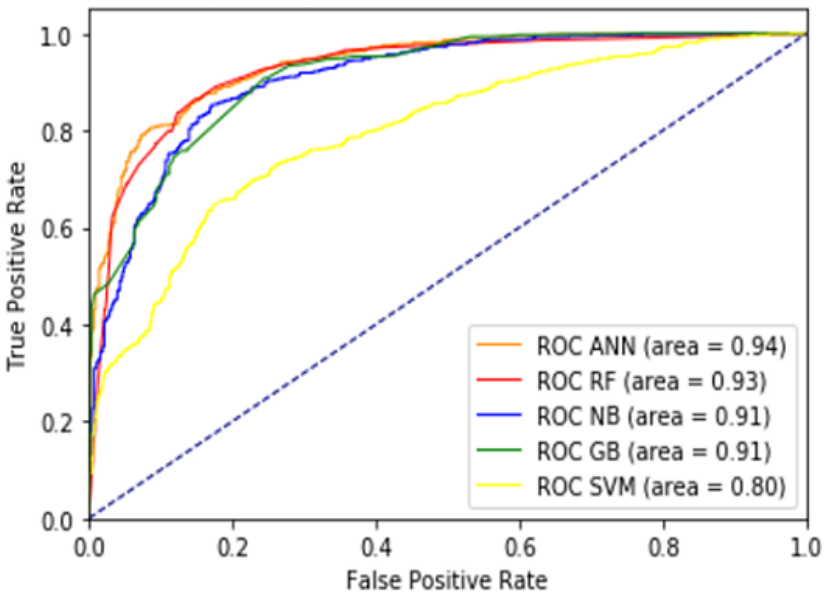
Figure 4. Performance of machine learning prediction models. ANN: artificial neural network; GB: gradient boosting; RF: random forest; NB: naïve Bayes; ROC: receiver operating characteristic; SVM: support vector machine.